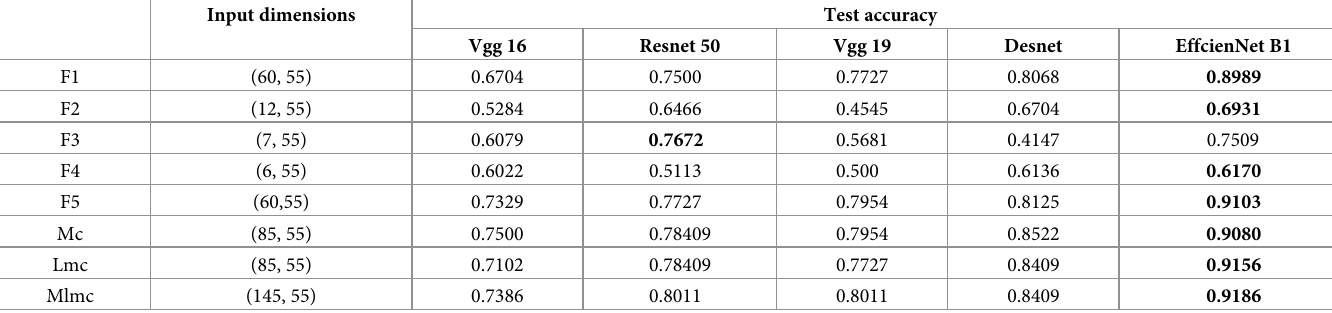
Table 3. Comparison table of experimental results of different features in different